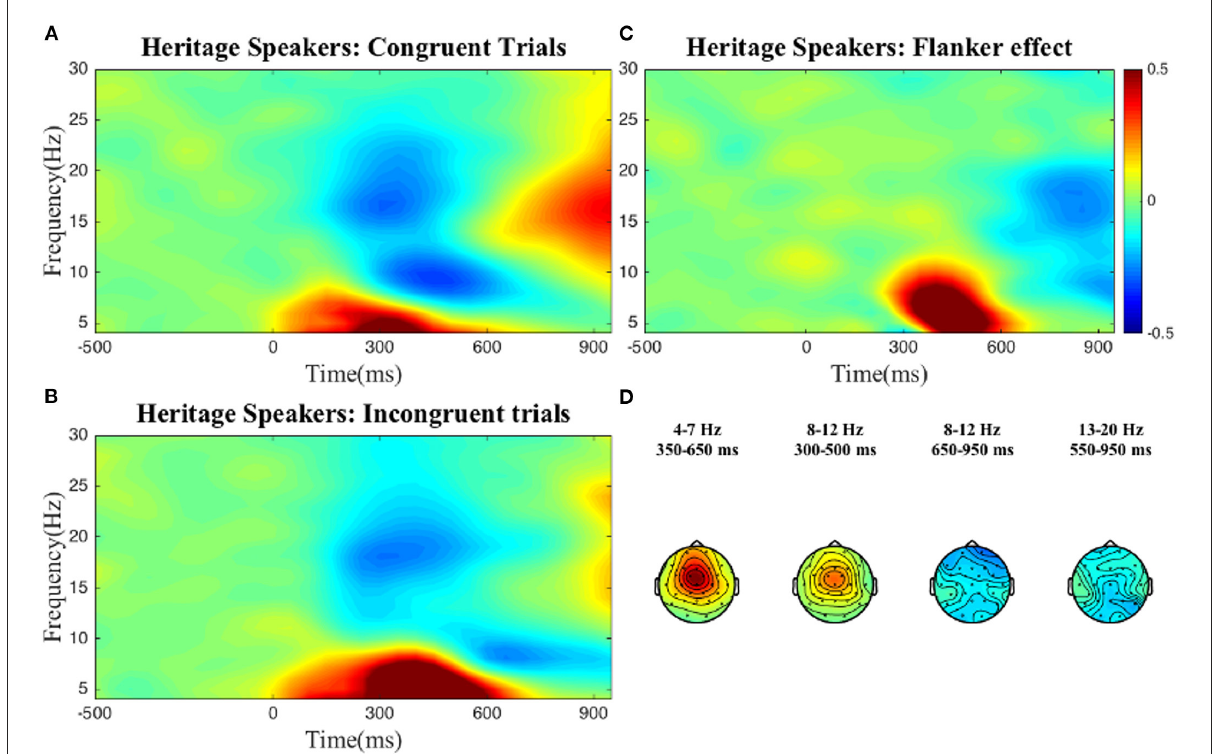
FIGURE2 TFRs for the HS group. Averaged time-frequency representations of individual conditions (A,B) and the Flanker effect (C) for the heritage speakers for 4–30Hz in a representative electrode, Cz and topographical plots (D) of the Flanker effect for the time-frequency clusters of interest. The Flanker effect was computed by subtracting power in the Congruent condition from power in the Incongruent condition. The color bar applies to both single electrode and topographical plots and indicates relative power change.